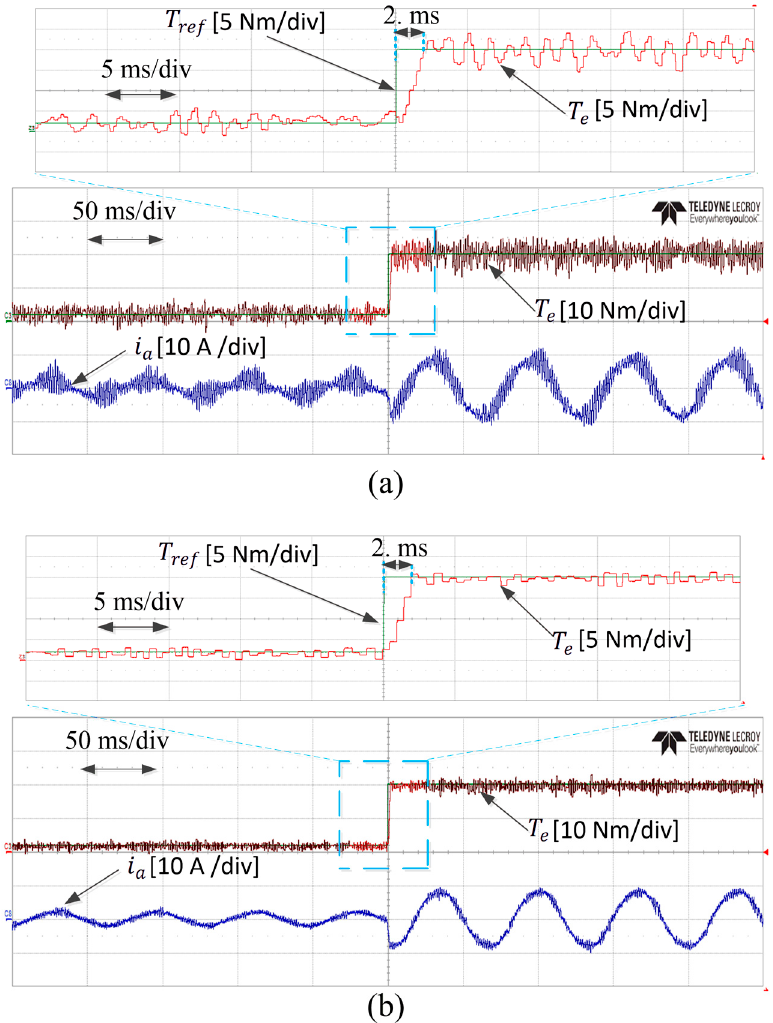
Figure 11. Experimental results of the torque step response from 2 to 20 Nm. ( a ) Conventional FS-PTC; ( b ) proposed PTC-DSVM.